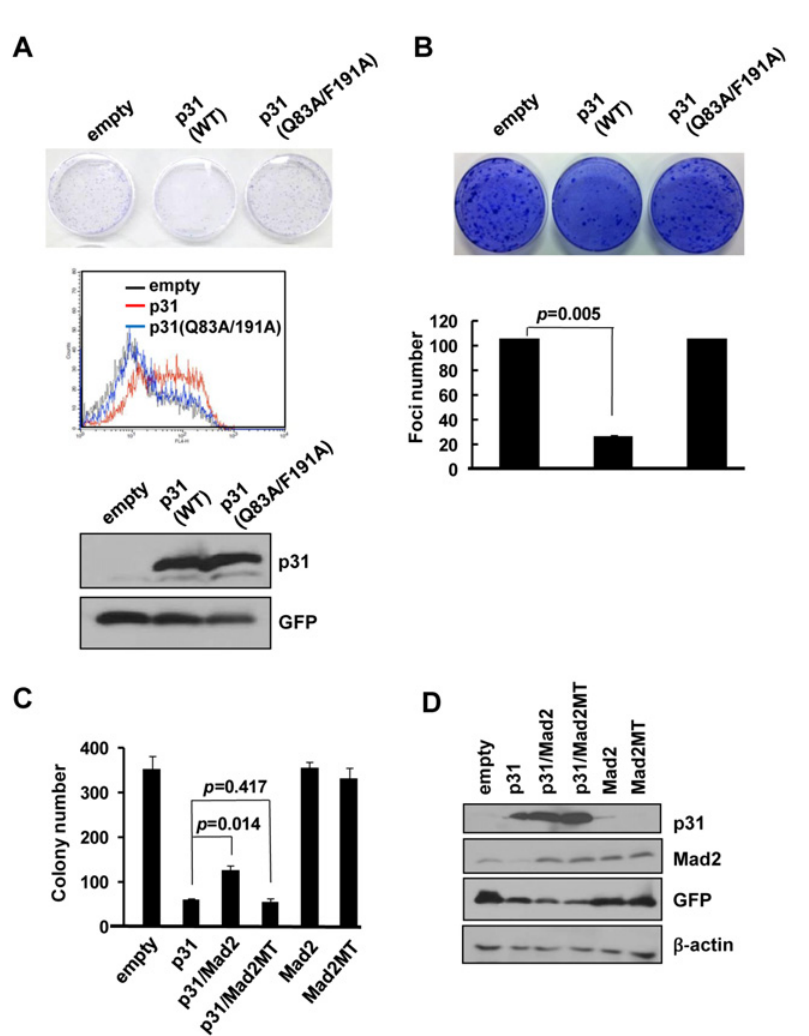
Fig 4. Mad2 binding activity is essential for p31 comet inhibition of colony formation. (A) Effects of a p31 comet mutant ( Q83A/F191A ) on apoptosis (lower panel) and repression of colony formation (upper panel) were analyzed in HeLa cells. Expression of p31 comet and Q83A/F191A was confirmed via Western blot. (B) The effects of a p31 comet mutant ( Q83/F191A ) on Myc/Ras -mediated colony formation in p53-/- MEFs were compared with those of wild-type (WT) p31 comet . (C) The effect of Mad2 on p31 comet -induced repression of clonogenic cell survival was analyzed in HeLa cells in the presence of either wild-type or dominant-negative mutant Mad2 ( R133E/Q134A ) (Mad2mt). (D) Expression of p31 comet , Mad2, and R133E/Q134A mutant (Mad2mt) was confirmed using immunoblotting. Values represent mean of triplicate samples. Statistical significance ( p- value) was calculated with Student ’ s t-test. * indicates p > 0.05, when each test transfection was compared with that of empty